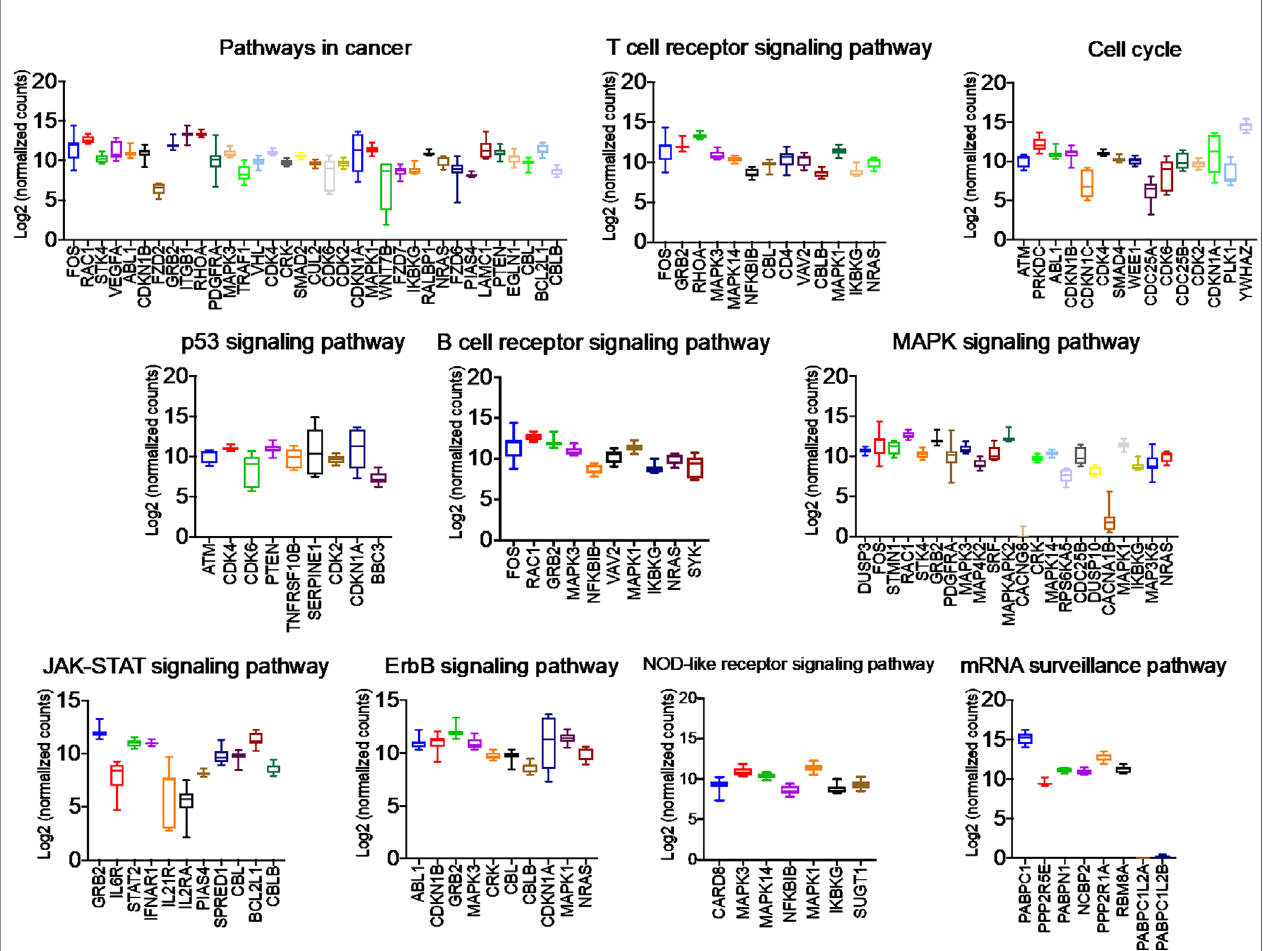
FIGURE 5 | Network analysis identi fi ed miRNA target genes to be upregulated in breast cancers following AG-205 treatment. The top upregulated miRNA target genes involved in KEGG pathway analysis have upregulated Log2 (normalized_counts) expression in metastatic breast tumor samples obtained from TCGA